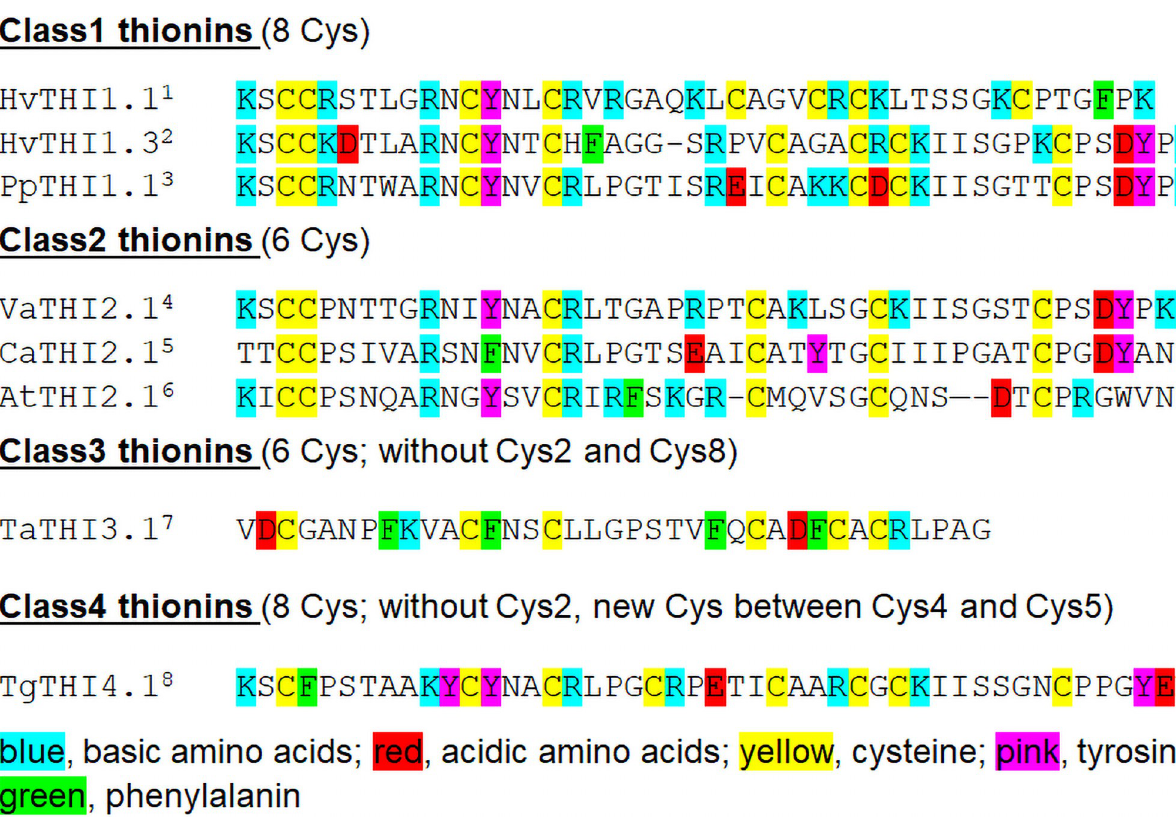
Fig 1. Examples of thionins including previous classification of thionins [18]. 1 HTH1, Hordothionin α [19]; 2 Barley leaf-thionin DB4 [20]; 3 Pyrularia thionin [21]; 4 Viscotoxin A3 [22,23]; 5 Crambin 2 [24,25]; 6 Arabidopsis thaliana thionin 2.1 [26]; 7 pTTH20 Neutral wheat thionin [27]; 8 Tulipa gesneriana thionin4.1 (Genbank, submitted by Luyten et al.